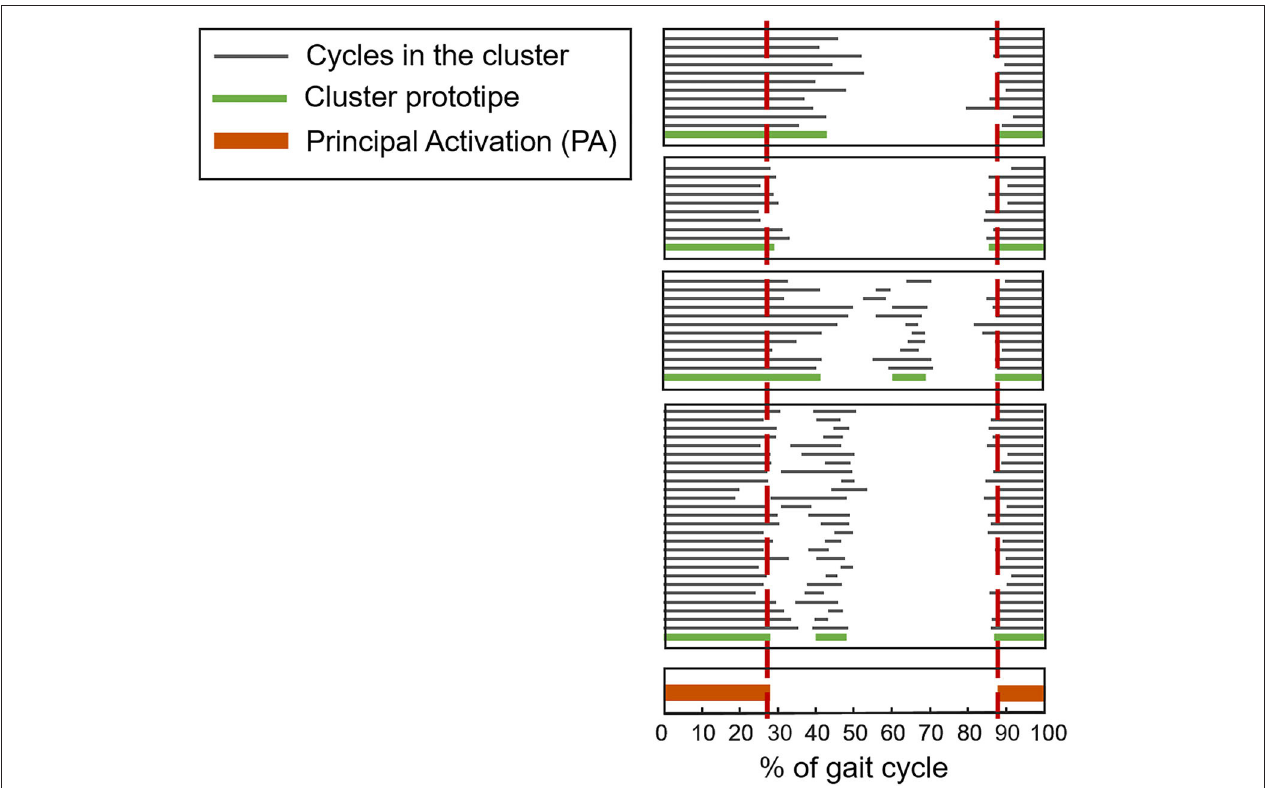
FIGURE 8 | Example of application of CIMAP (Clustering algorithm for Identification of Muscle Activation Patterns) for the Rectus Femoris muscle. Gray bars represent the activation intervals in different gait cycles of the same walk. The Principal Activation (PA) is univoquely determined as the intersection of cluster’s